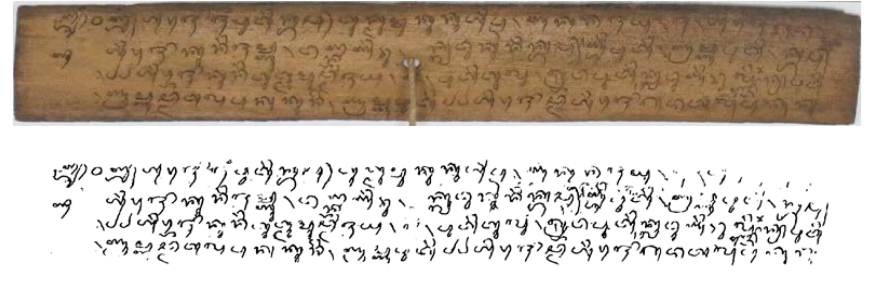
Figure 22. Binarization of Balinese manuscript with ICFHR G2 method.